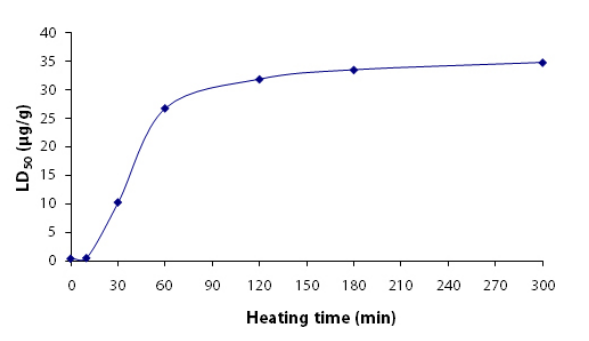
Figure 2. Change of LD 50 value of heated cobra venom. Dissolved Naja naja venom was first heated at 100°C for 10, 30, 60, 120, 180 or 300 minutes, than centrifuged at 15,000 g/minute for 30 minutes and the supernatant of each portion was injected into mice to determine the LD 50 (µg/g) according to the mathematical scheme of Meier and Theakston (14).